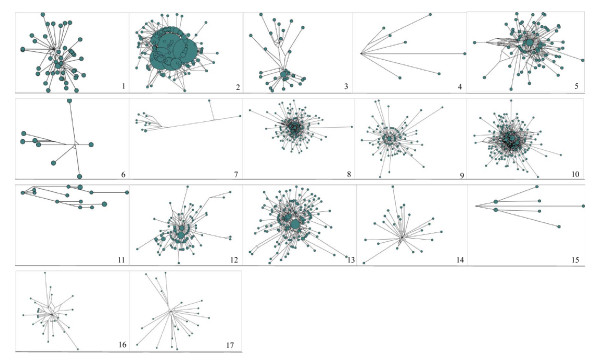
Median-joining networks of 17 silkworm MITE families. 1 to 17 represent BmMITE-1 to BmMITE-17 family, respectively. The circle, circle area and branch length represent MITE sequence, proportional to the number of identical copies and proportional to the number of nucleotide changes, respectively.